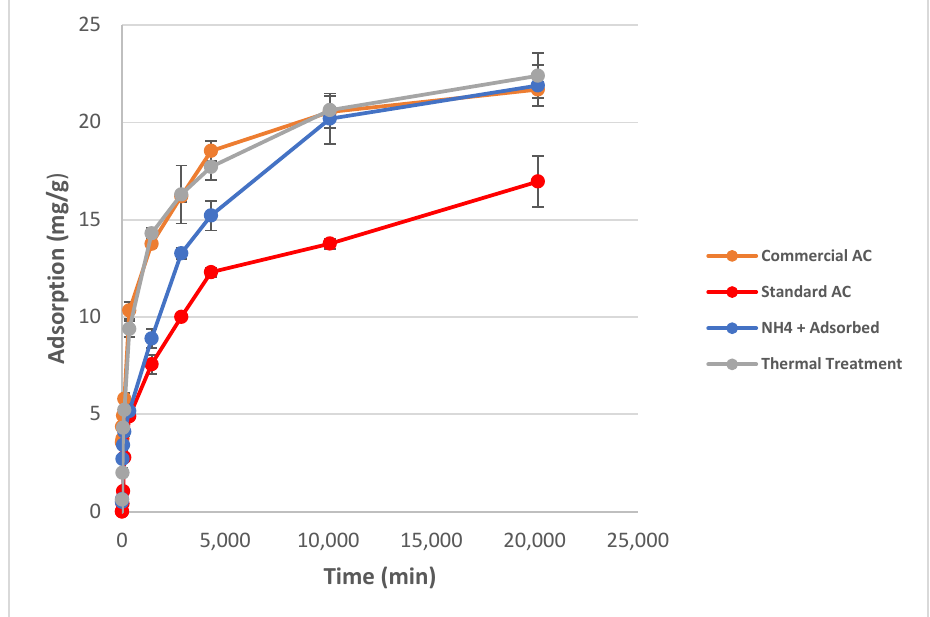
Figure 2. Kinetics curve of the produced activated carbons compared to the commercial AC. Results show 92% adsorption of total chromium (approximately 22 mg/g) in all activated carbons after two weeks with the exception of the standard AC which shows 64% total chromium adsorption (approximately 17 mg/g). Maximum possible adsorption (i.e., 100%) is 25 ± 1 mg/g. When adsorption results are normalized to 1000 m 2 , the petroleum coke-based acti- vated carbons that were produced showed higher adsorption capacities than the commer- cially available activated carbon in units of mg Cr (VI) adsorbed/1000m 2 surface area. This is shown in Figure 3. This indicates that the surface chemistry of the activated carbons plays a more important role in the adsorption than the surface area of the activated carbon as similar adsorption results can be achieved with activated carbons of lower surface area by simply changing the surface